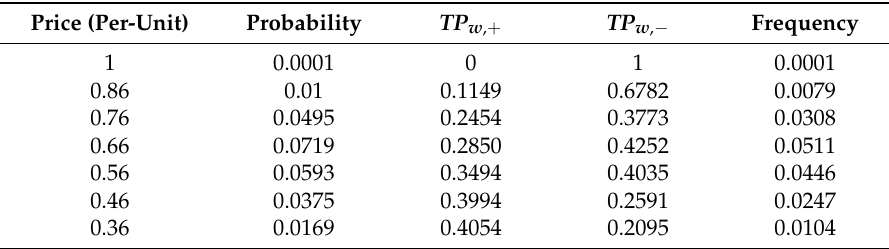
Figure 2. Market price data (summer). Table 3. Market price stochastic model.